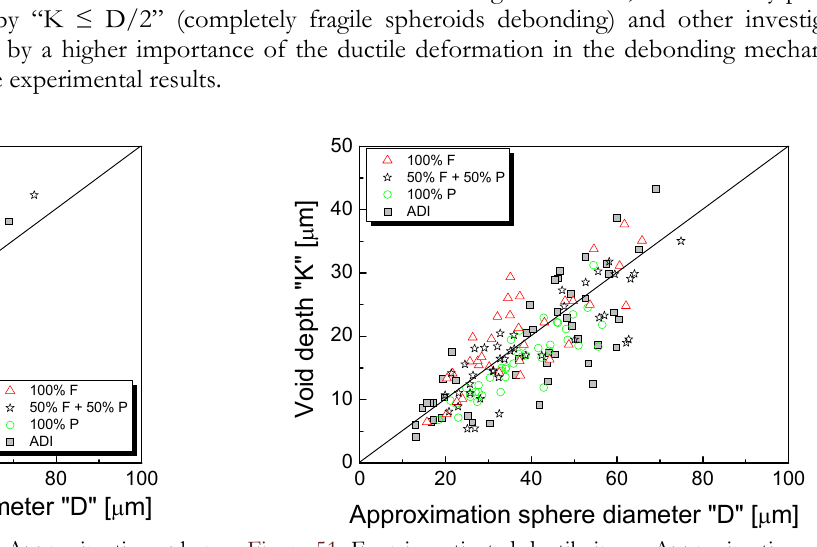
Figure 51: Four investigated ductile irons. Approximation sphere diameter – void